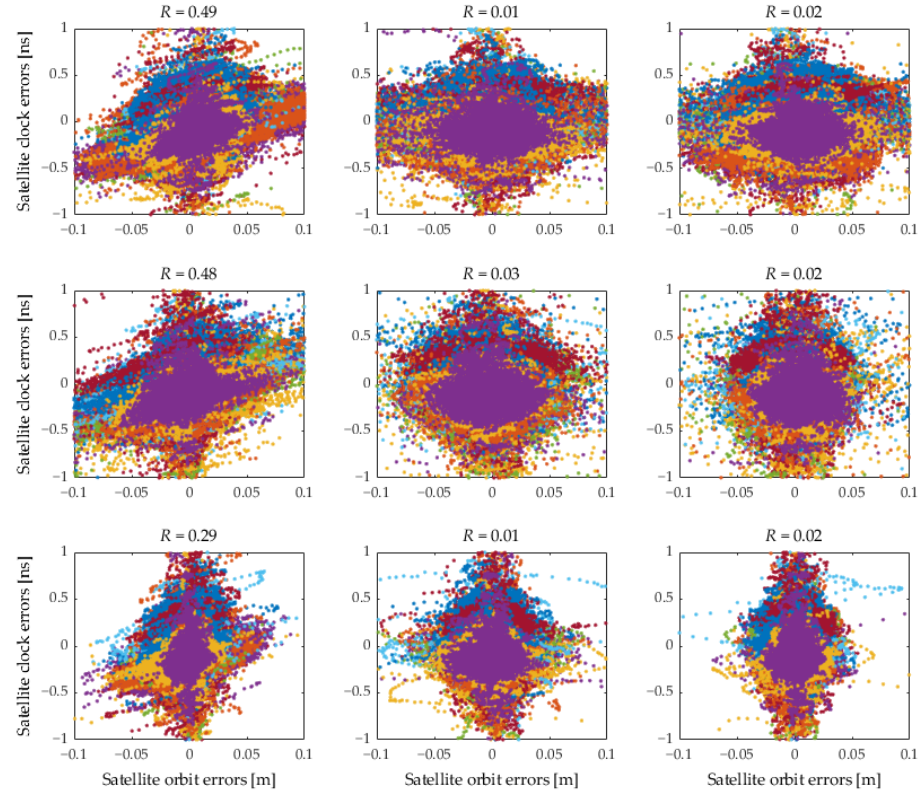
Figure 3. Correlation between batch-estimated satellite clock errors and fixed satellite orbit errors for one year. The row panels from top to bottom show the results based on the fixed satellite orbit product provided by WHU, GFU and IGU, respectively. The column panels from left to right show the results of the satellite orbit error in the radial, along-track and cross-track directions. The dots with different colors represent different satellites.